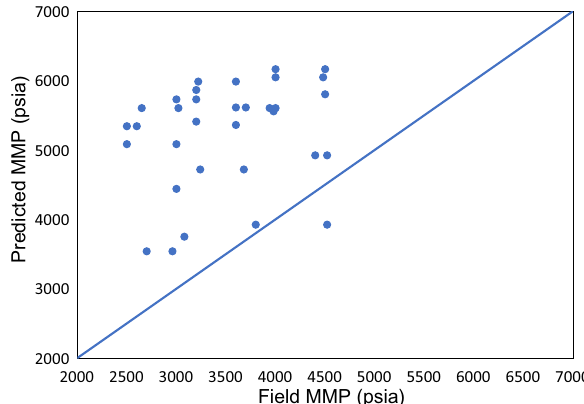
Fig. 7 Cross-plot of MMP testing data for the new model